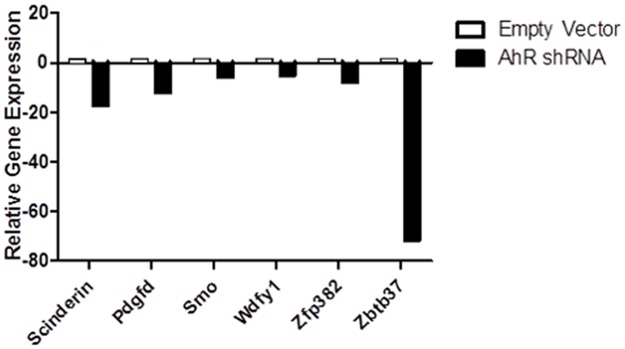
Lentiviral-mediated knockdown of AhR promotes changes in expression in candidate AhR target genes in Lin- hematopoietic cells.Lentiviral vectors encoding TRC0000226025 (AhR-shRNA) were used to transduce primary murine lin- cells. A fold change of at least 1.5 was considered significant. Relative gene expression was calculated using GAPDH and HPRT as endogenous controls. Data expressed as samples transduced with viral particles encoding AhR-shRNA relative to empty vector control. A fold change of at least 1.5 was considered significant. N = 4 per group.